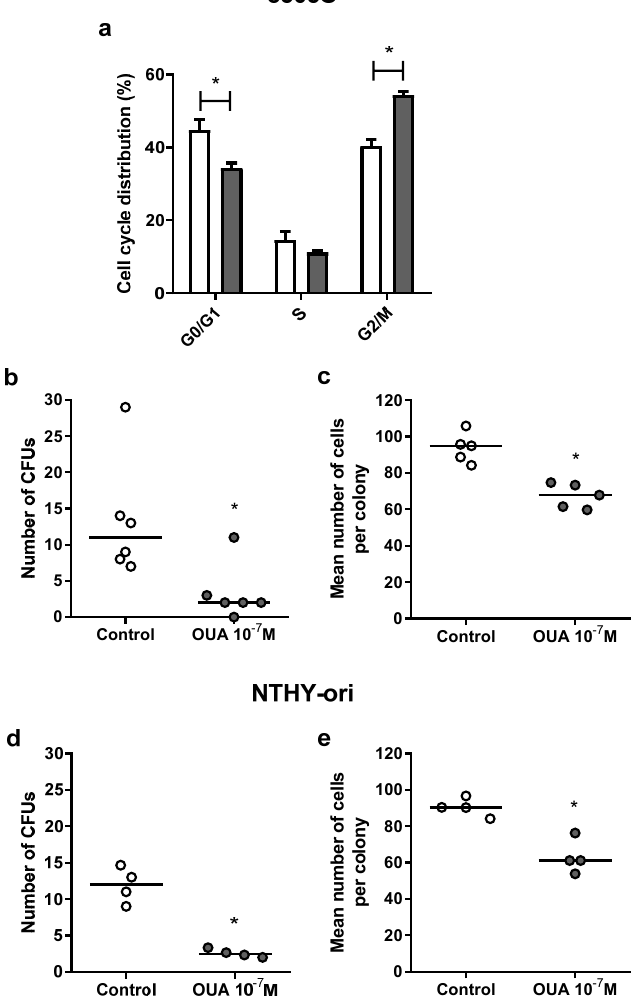
Figure 3. Effect of ouabain on 8505C cell cycle distribution and 8505C and NTHY-ori CFU formation. 8505C and NTHY-ori cells were cultured in the absence or presence of ouabain 10 − 7 M. ( a ) Cell cycle distribution was analyzed using Muse Cell Cycle Kit. Data are expressed as the mean percentage of 8505C cells ± SEM in G0/G1, S and G2/M phases after 24 h of culture (n = 4). ( b – e ) Tumor cell colony-forming units were also analyzed after 7 days of culture. Graphs are presented as the number of CFUs and the mean number of cells per colony in 8505C (( b , c ), respectively) and NTHY-ori (( d , e ), respectively) ouabain-treated and control cultures (n ≥ 4). * p < 0.05 using paired t-test.